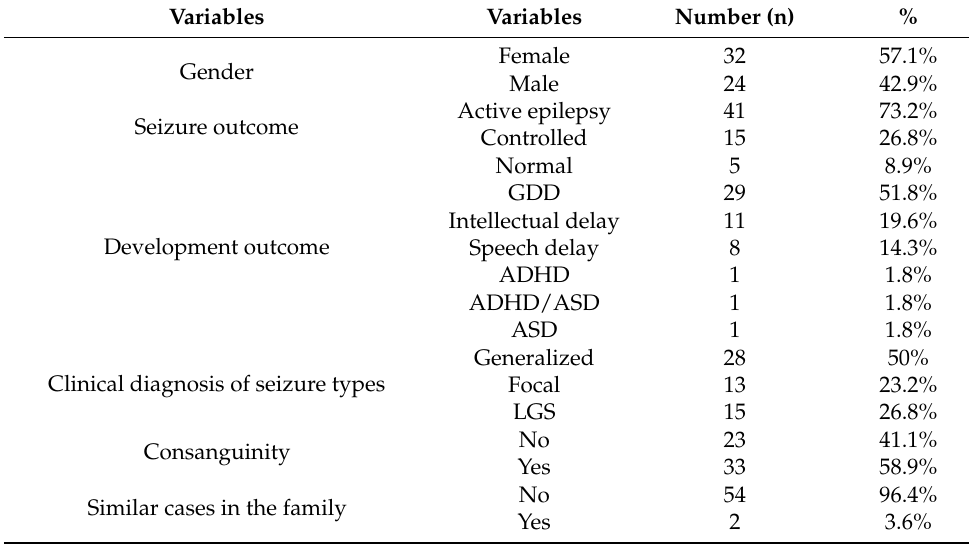
Table 1. Summary of clinical characteristics of the cohort.